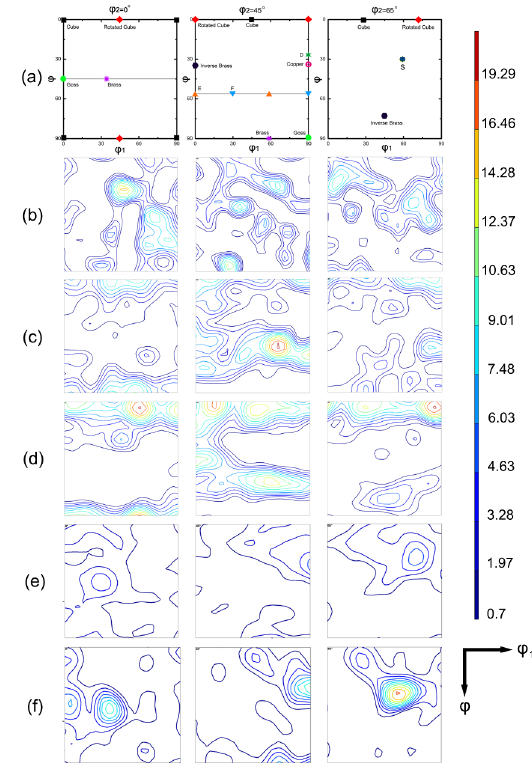
Figure 3. (a) standard ODFs and ODFs of the samples (b) 0, (c) HR30, (d) HR50, (e) HR+CR70 and (f) HR+CR90. stronger and the texture S{123}<634> is the strongest, as shown in Figure 3f. The volume fraction of different texture components are calculated from bulk texture analysis of the specimens. Trends of all the textures are shown in Figure 4a. The sample after homogenization treatment shows random orientation, without obvious texture. The evolution of the texture obviously divided into two groups. The groups of the shear textures and the recrystallization textures represented by dotted line and black line are dominant during the hot rolling deformation. During the cold rolling deformation, the group of the rolling textures represented by thin lines becomes stronger, and the shear textures and recrystallization textures become weaker. Figures 4b-4d shows the evolutions of the recrystallization texture, shear texture and rolling texture, respectively. Figure 4b shows the evolution of Cube texture. The volume fraction of Cube texture increases with increasing the hot rolling deformation degree. During the cold rolling deformation, the volume fraction of Cube texture decreases rapidly. Figure 4c shows the evolution of the shear textures. E texture and F texture are constantly strengthened with increasing the hot rolling deformation degree. Rotated cube texture and Inverse brass texture reach the maximum volume fractions for the sample HR30 and these textures become slightly weaker for HR50. Figure 4d shows the evolution of the rolling